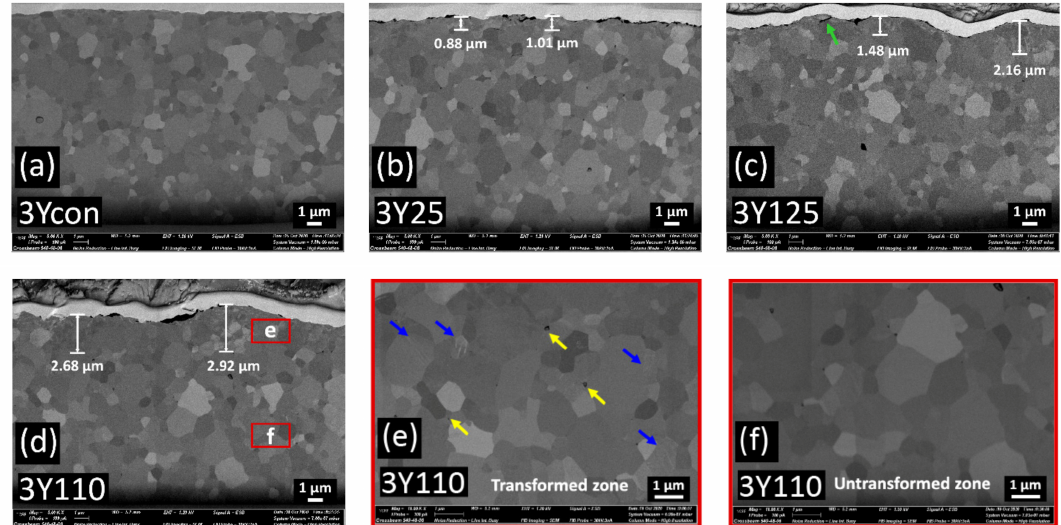
Figure 7. FIB cross-sections of ( a ) 3Ycon, ( b ) 3Y25, ( c ) 3Y125, ( d ) 3Y110; the thin boxes indicate the locations of details ( e , f ). ( e ) detail of the transformed zone of 3Y110, ( f ) detail of the untransformed zone of 3Y110. In detail ( e ), the transformed monoclinic grains with twinning are indicated by the blue arrows and the small pores are indicated by the yellow arrows. No microcracks are detected. In detail ( f ), there is no transformed grain. The small microcrack (shown in green arrow) is detected close to the surface in 3Y125.